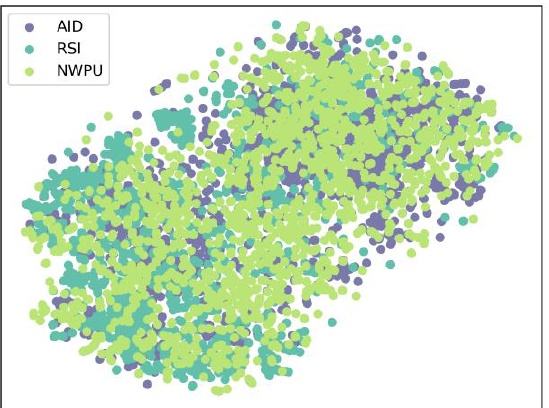
Figure 5. 2-D scatter plots for three scenes datasets in feature space, which was generated with the t-SNE algorithm.